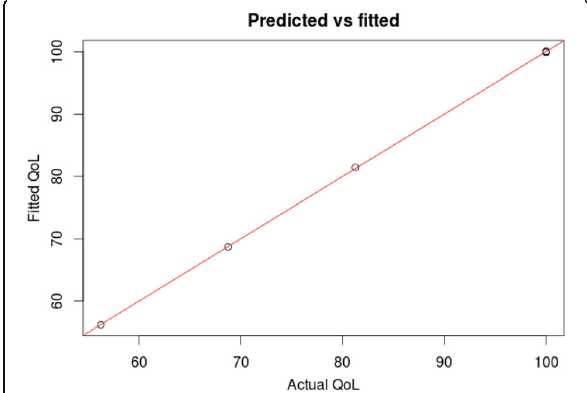
Fig. 4 Multiple regression model incorporating patient GAG levels pre- and post-surgery and MMP3 levels post-surgery to predict patient quality of life. The model shows quality of life (QoL) fits with an R 2 of 0.9998 and a p value=0.0087